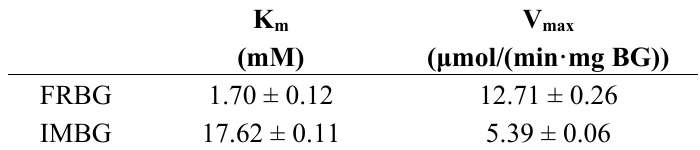
Table 2. K m and V max of β -glucosidase on cellobiose: Free (FRBG) and immobilized (IMBG).